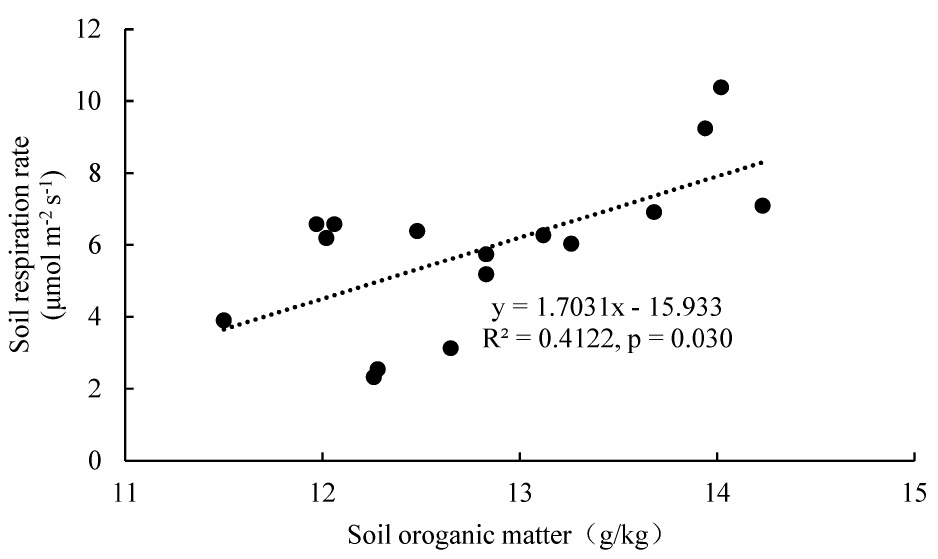
Figure 7. The relationship between soil organic matter and soil respiration